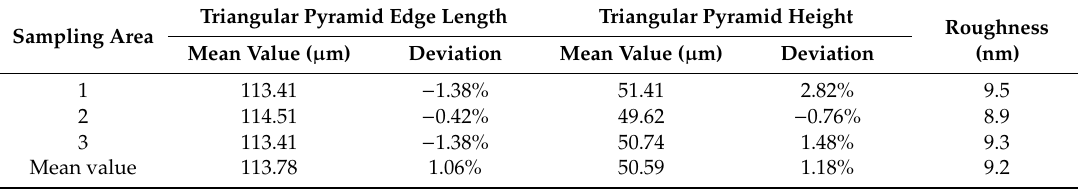
Table 3. Measurement of the triangular pyramid microstructure size and roughness.